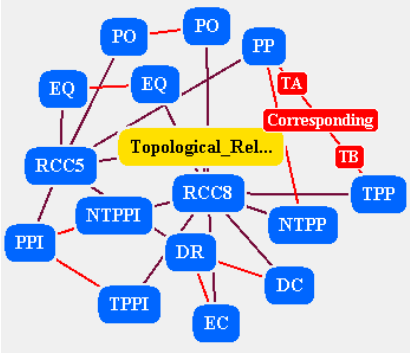
Figure 8. Topic map of RCC5 and